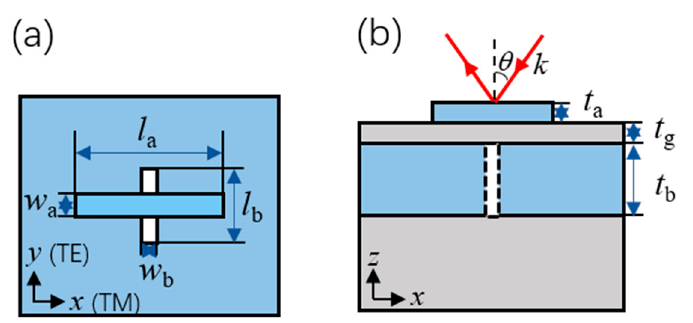
Figure 1. Schematic illustration of the high extinction ratio nano-system: ( a ) top view and ( b ) side view.